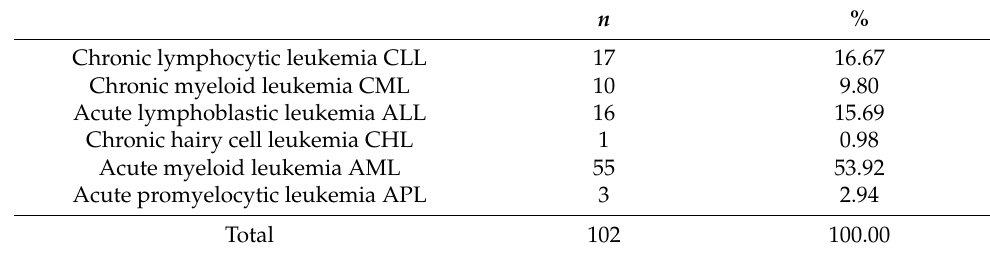
Table 2. The type of leukemia in the study group.